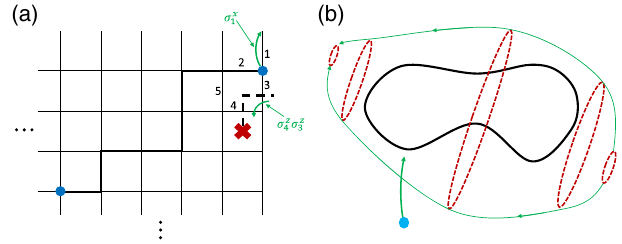
FIG. 4. (a) Prethermalization does not protect against qubit errors at the boundaries between “ rough ” and “ smooth ” edges of the toric code on a surface with boundary. Here, an e particle (blue dot) is absorbed by the rough boundary (top edge), while an m particle (red cross) is emitted by the neighboring smooth boundary (right edge), as described in the text. (b) When a qubit is encoded in a loop that carries “ Cheshire charge ” in 3D, errors associated with a magnetic flux loop encircling (sequence of dotted red lines, whose growth and subsequent shrinkage are indicated by the green arrows) the Cheshire loop are suppressed by the size of the Cheshire loop, since the magnetic flux loops have a line tension at temperatures below the bulk phase transition temperature. There is no such protection against the emission or absorption of a pointlike electric charge (blue circles), even below the phase transition temperature into the topological phase. However, prethermalization can suppress such processes